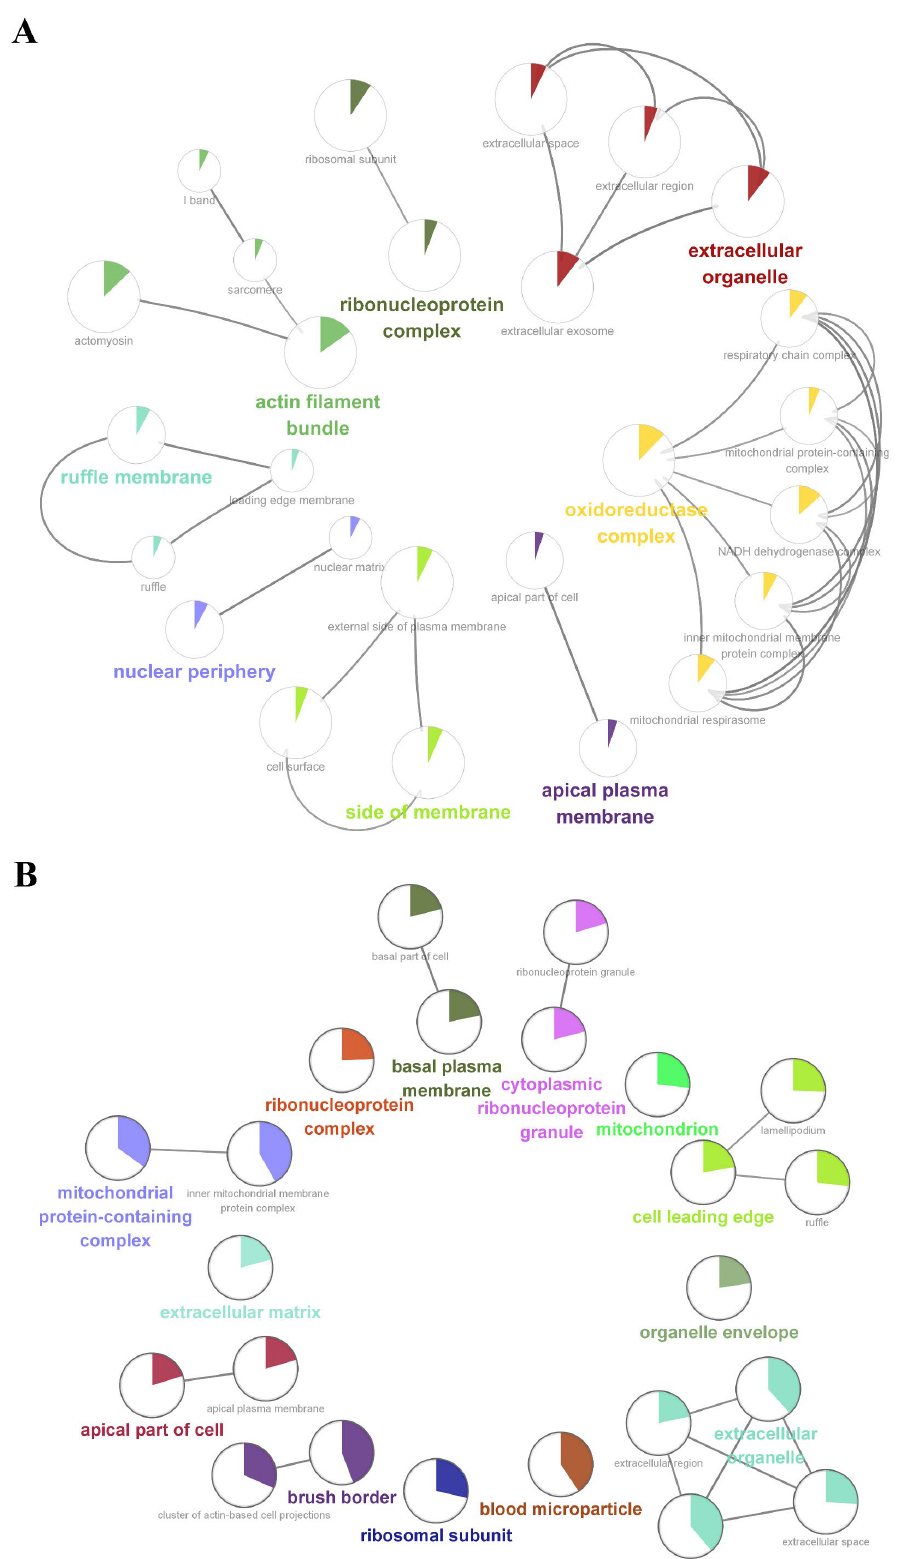
Figure 3. Cellular localization enrichment analysis of the SNO-proteome and proteome. ( A ) Cellular localization enrichment analysis of the SNO-proteome; ( B ) cellular localization enrichment analysis of the proteome.